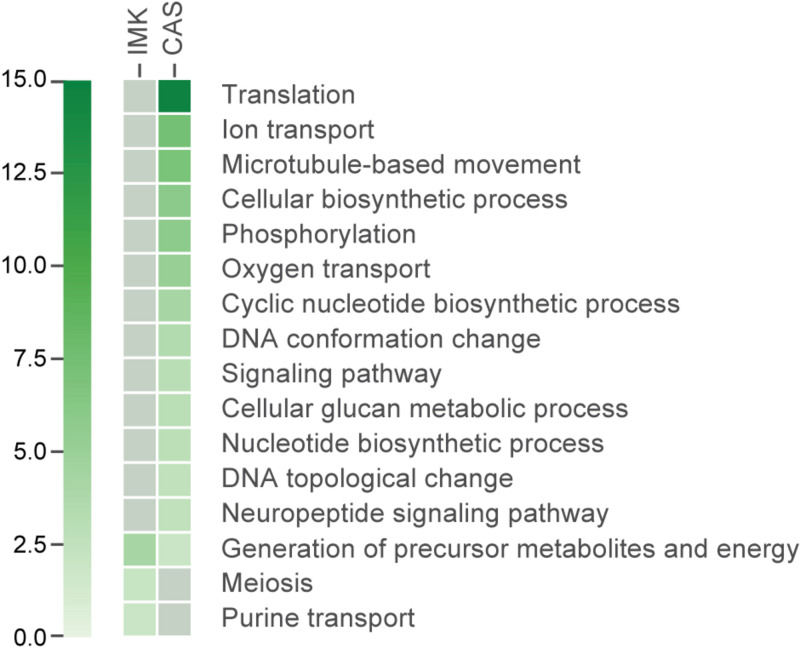
The GO categories enriched (based on adjusted hypergeometric p-value < 0.1) in the transcripts showing significant differential expression. Heatmap showing the p-value for the enrichment of each category. Gray colored boxes indicate not significant.